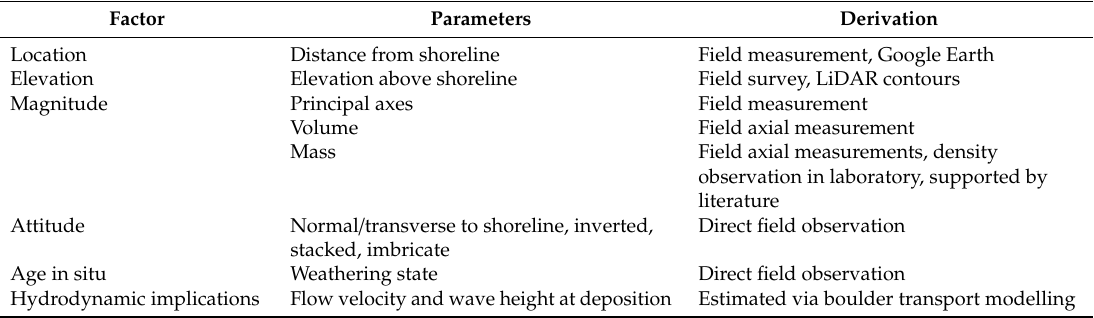
Table 1. Summary of parameters employed and their